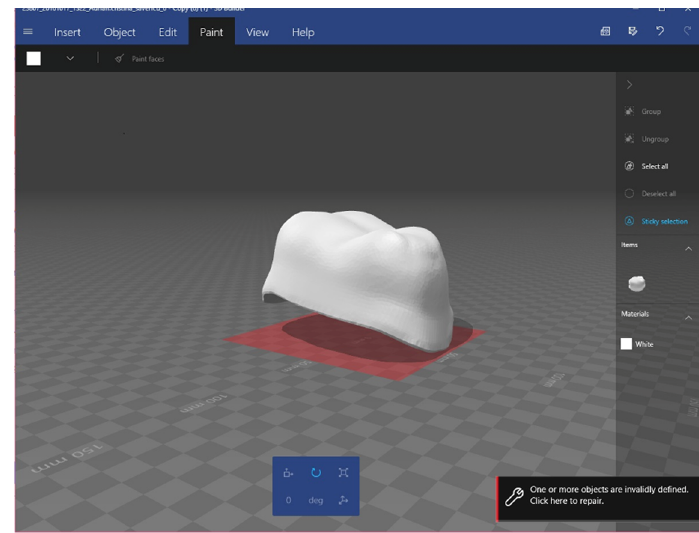
Figure 3. Framework design.